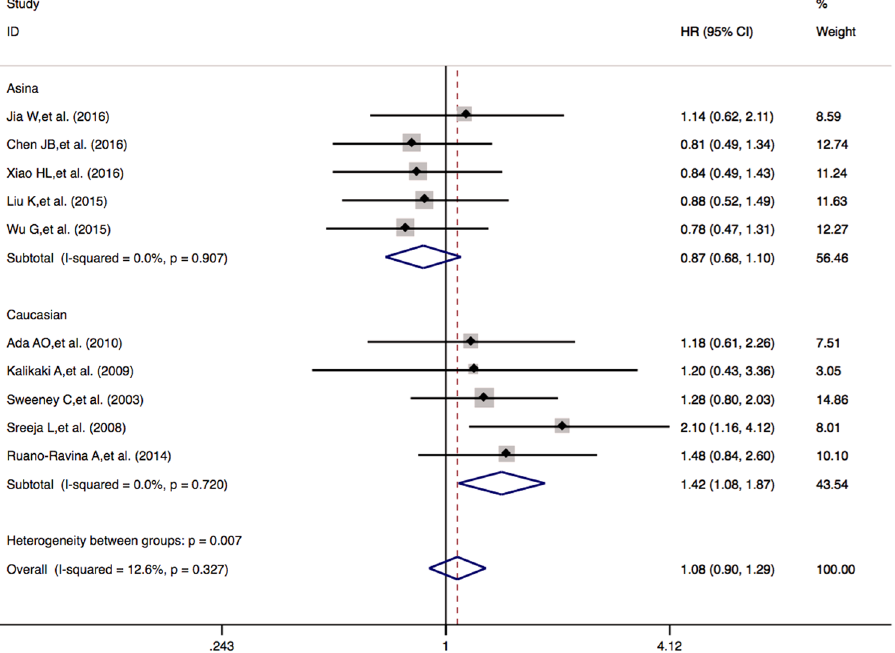
Figure 4. Forest plots of OS in NSCLC patients treated with platinum-based chemotherapy by the GSTM1 null or present polymorphism (null vs . present). Hazard ratios (HRs) (and its 95% confidence interval (CI)) of overall survival (OS) stratified by ethnicity for the GSTM1 null or present polymorphism null vs .